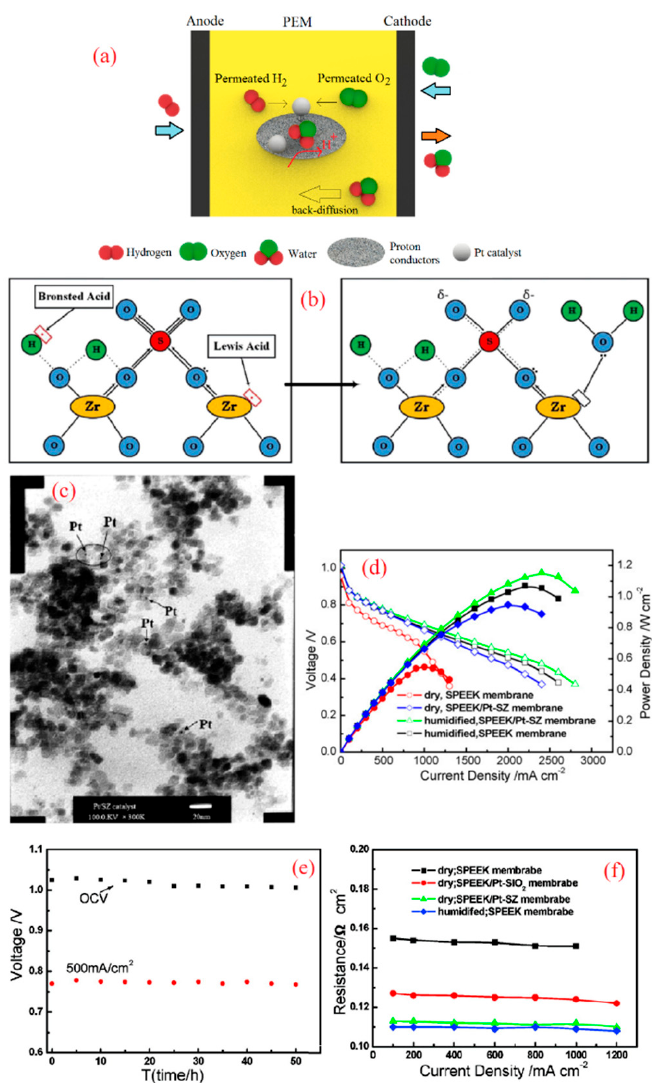
Figure 4. ( a ) Schematic demonstration of a self-humidifying PEM incorporated with proton conductors, ( b ) Bronsted acid sites act as additional acidic sites for proton conduction in sulfated zirconia (SZ) (reprinted with permission from [67]); ( c ) TEM image of Pt–SZ nanoparticles with Pt loading of 2 wt % and ( d ) fuel cell performance of plain SPEEK and Pt–SZ/SPEEK membranes at 60 ◦ C (reprinted with permission from [68]); ( e ) 50 h fuel cell test for Pt–SZ / SPEEK at 60 ◦ C and dry condition and ( f ) areal resistance of plain and nanocomposite SPEEK membranes as a function of current density (reprinted with permission from